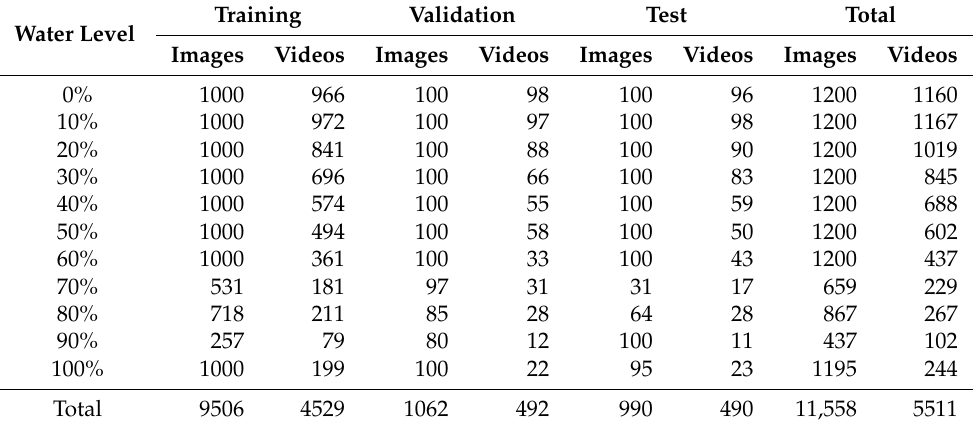
Table 1. Overview of the dataset and the three splits. The data are annotated following the 2010 Danish sewer inspection